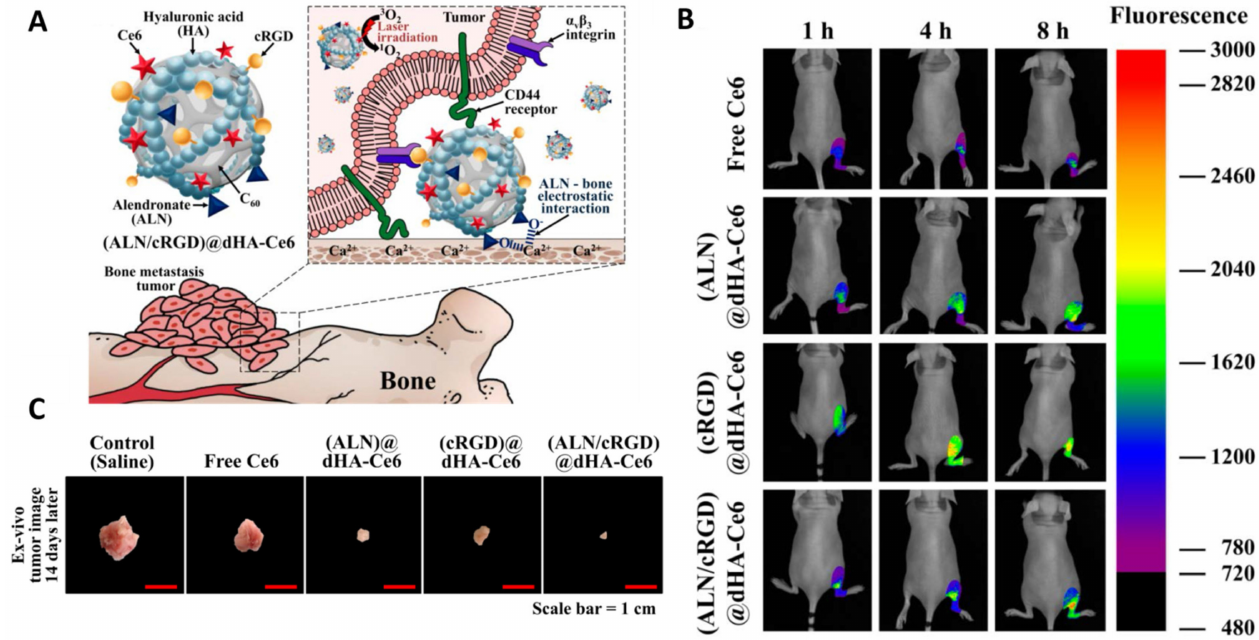
Figure 2. ( A ) Schematic illustration of (ALN/cRGD)@dHA-Ce6. ( B ) In vivo noninvasive photoluminescent tumor imaging of free Ce6 (2.5 mg/kg) or each sample (equivalent Ce6 2.5 mg/kg) intravenously injected into MDA-MB-231 tumor-bearing nude mice. Fluorescent tumor images of the limbs were obtained at 1, 4, and 8 h post-injection. ( C ) Optical images of tumor samples extracted from MDA-MB-231 tumor-bearing nude mice. Reproduced from ref. [106] with permission from MDPI AG. Copyright (2020)